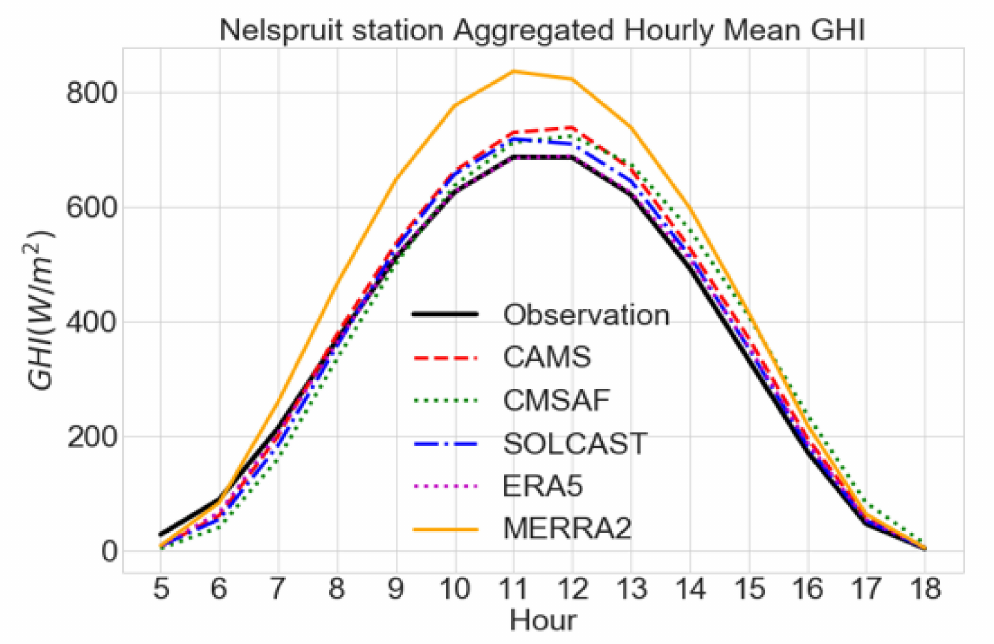
Figure 9. Aggregated measured and estimated hourly GHI values in values in Nelspruit. The aggregated GHI Observation period for each station is given in Table